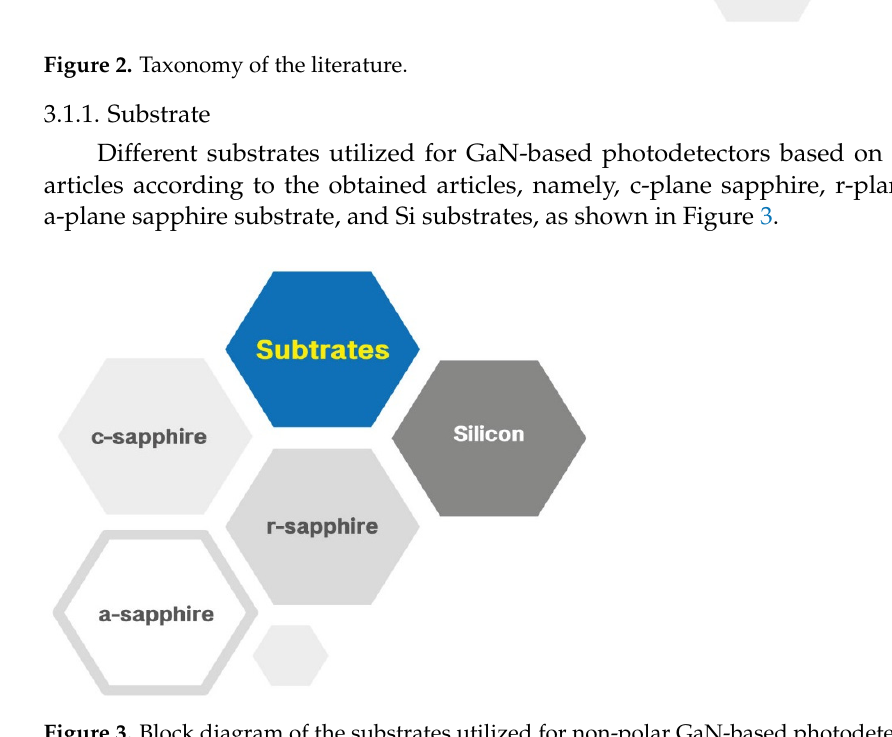
Figure 3. Block diagram of the substrates utilized for non-polar GaN-based photodetectors.